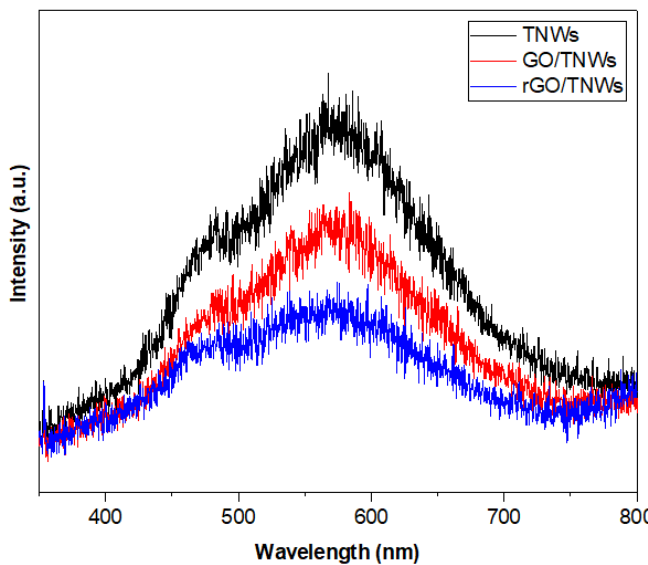
Figure 7. Photoluminescence spectra of TNW, GO/TNW, and rGO/TNW samples. Table 1 compares this work with recent literature on the photoreduction of Cr(VI) [45–51]. It is evident that the photocatalytic reduction of rGO/TNWs formed in this work is comparable, if not superior, to the rGO/TiO 2 (nanoparticles) composite under visible light irradiation. Moreover, it is known that the addition of a scavenger can improve the efficiency of Cr(VI) photoreduction. There are several types of scavengers that can be used, and phenol is one of them. It can be seen from Table 1 that reduction in the presence of phenol (10 mM) is slower [46] than that of EDTA (this work), thus, concluding that EDTA is perhaps a better scavenger for this purpose. Table 1. Comparison of obtained Cr(VI) reduction efficiency with recent studies under UV–Vis light irradiation (RGO = reduced graphene oxide; C = carbon). Photocatalysts